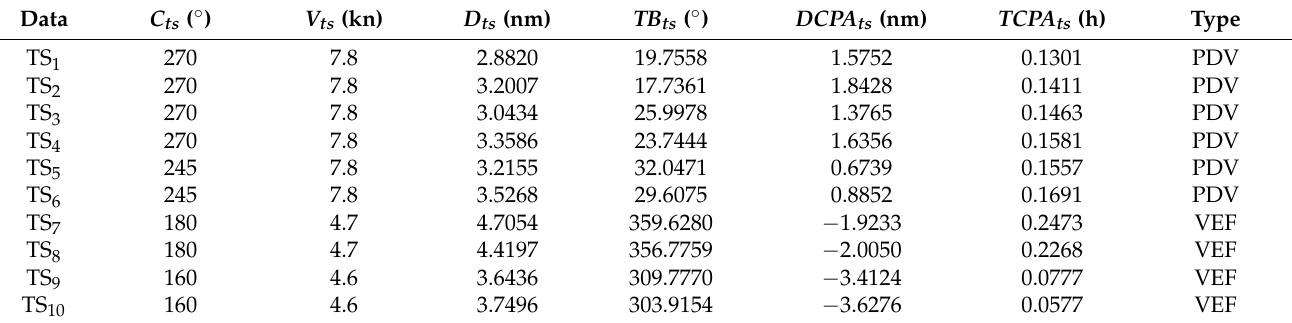
Table 4. Data of target ships at